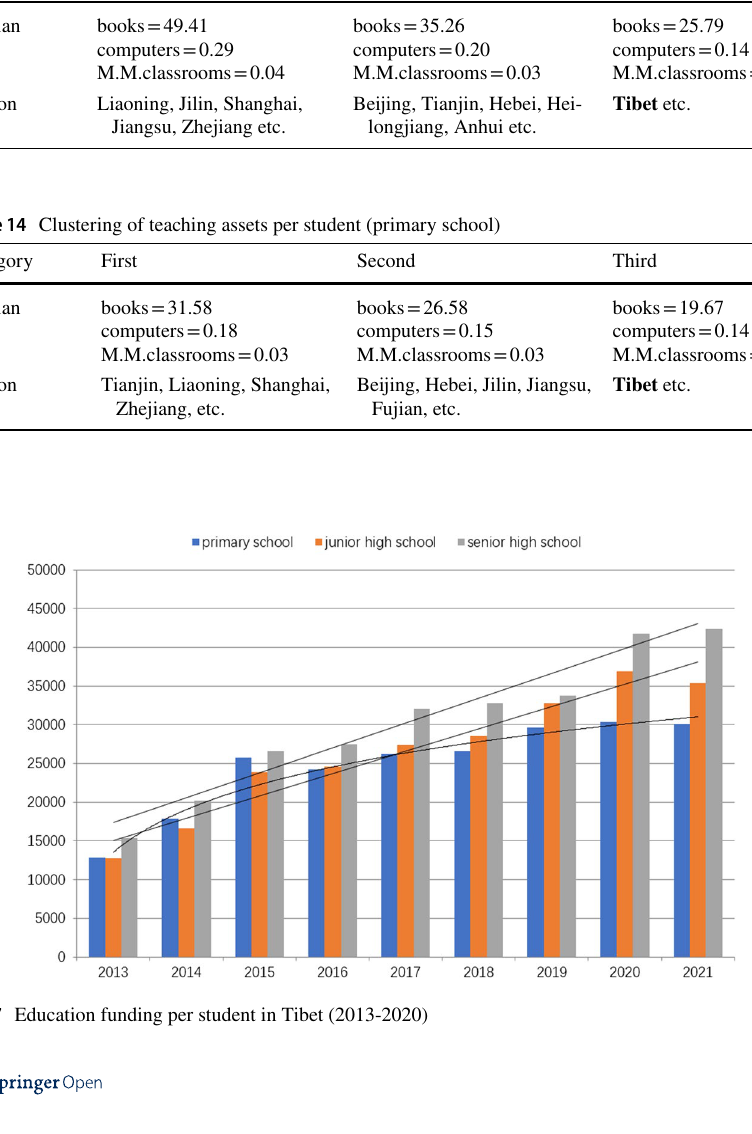
Table 13 Clustering of teaching assets per student (junior high school) Category